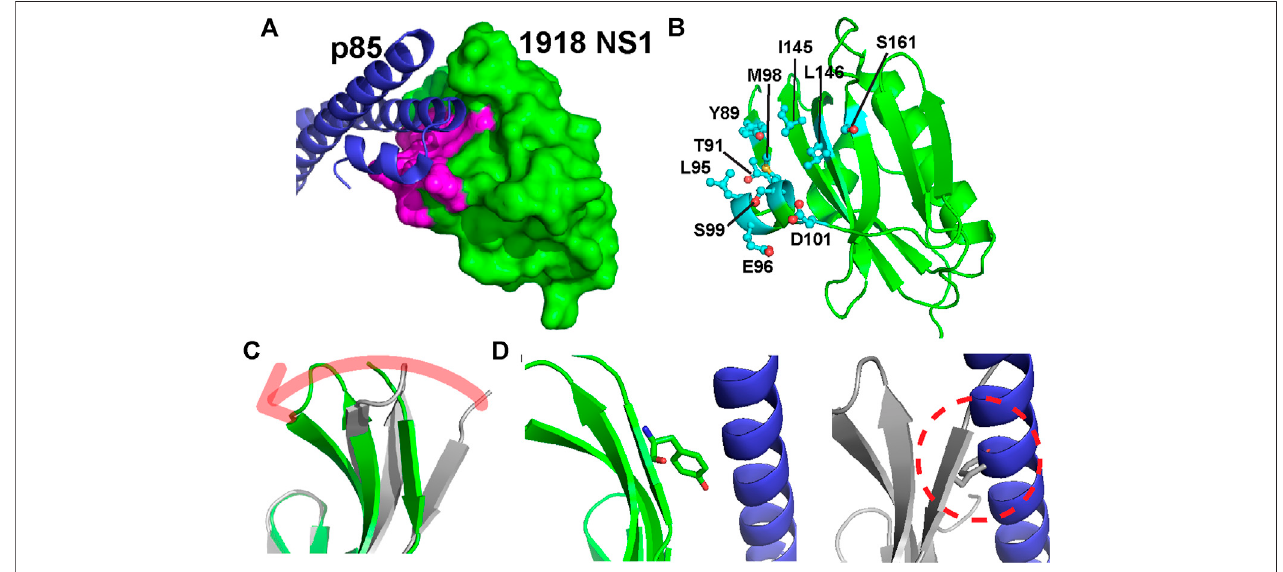
FIGURE 2 | (A) Structure of the 1918 NS1:p85 β complex (PDB ID: 6U28). Binding interface residues on 1918 NS1 included in the present study are shown in magenta (B) The Ala-substituted residues on 1918 NS1 are shown in a stick model. The orientation of 1918 NS1 is the same as in panel A (C) Overlay of 1918 NS1 structures of the free (gray) and p85 β -bound (green) states. Arrow shows the direction of conformational change upon binding to p85 β (D) Conformations of Y89 in the bound (leftpanel) andfree (rightpanel) statesof1918NS1.DashedcircleshowsthehypotheticalstericclashofY89withp85 β whenfree1918NS1isdockedto the complex